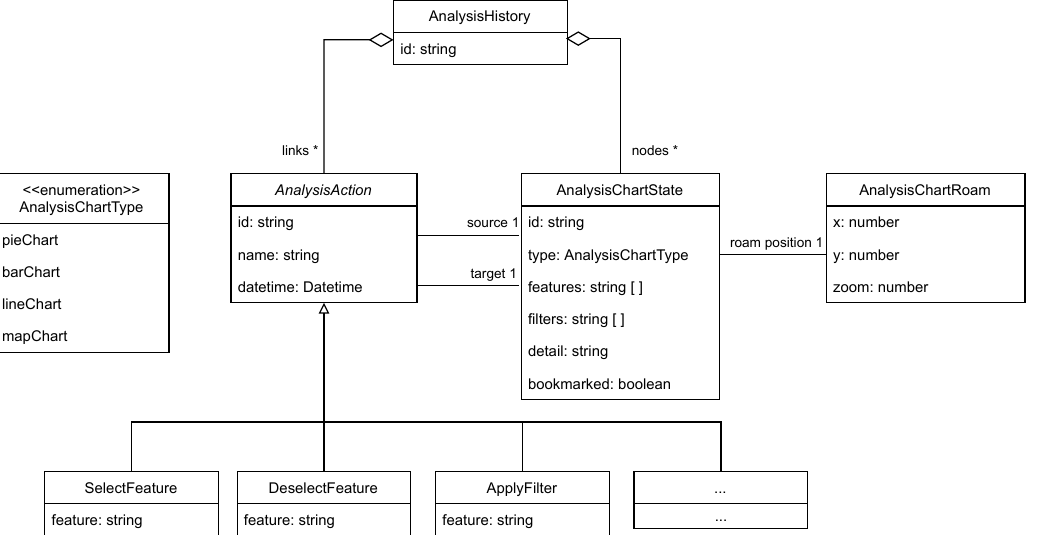
Figure 4. UML diagram of the implementation of our interaction model.